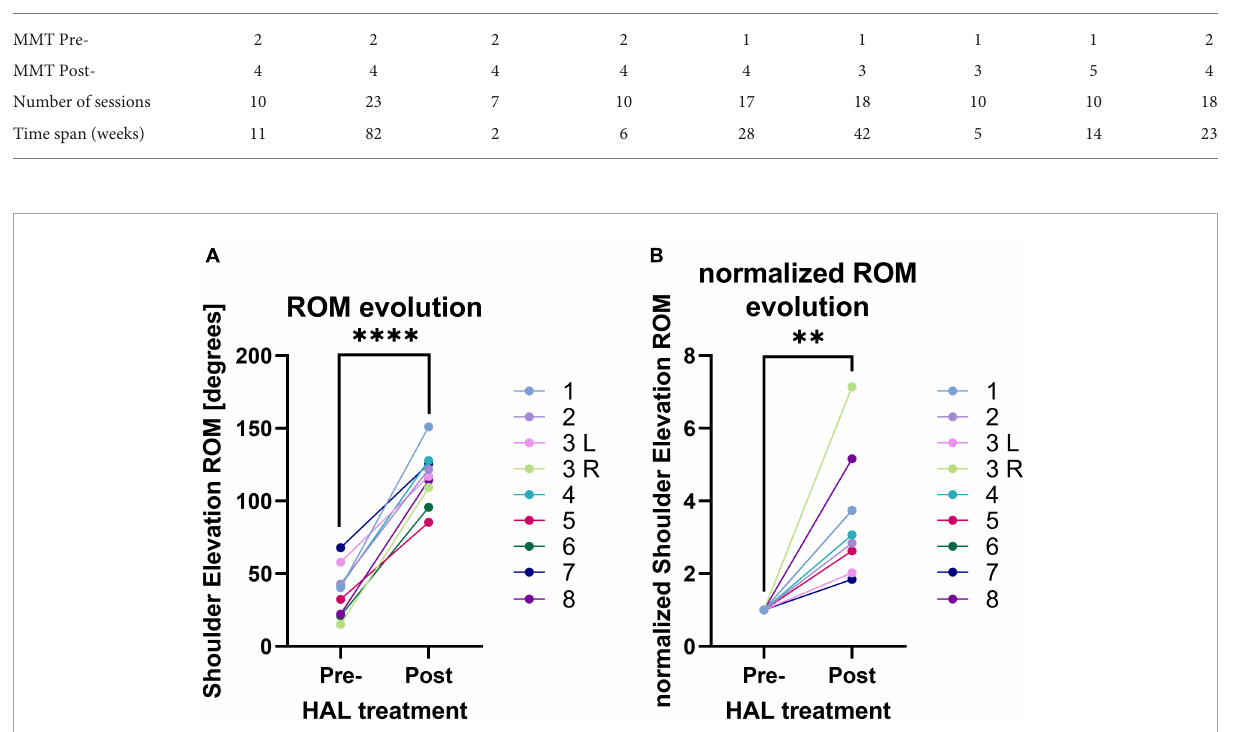
FIGURE2 (A) Range of Motion (ROM) of shoulder elevation angle before and after HAL treatment. (B) Normalized ROM of shoulder elevation angle before and after HAL treatment.